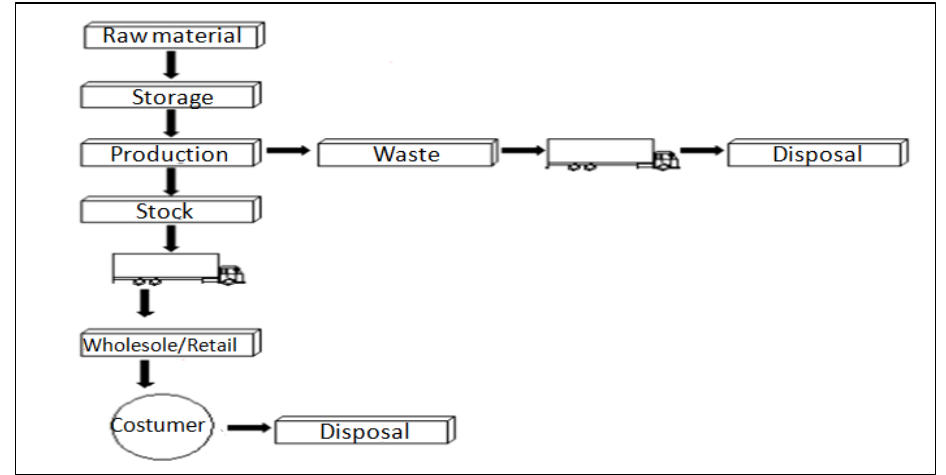
Figure 4: Product life cycle in the studied company.